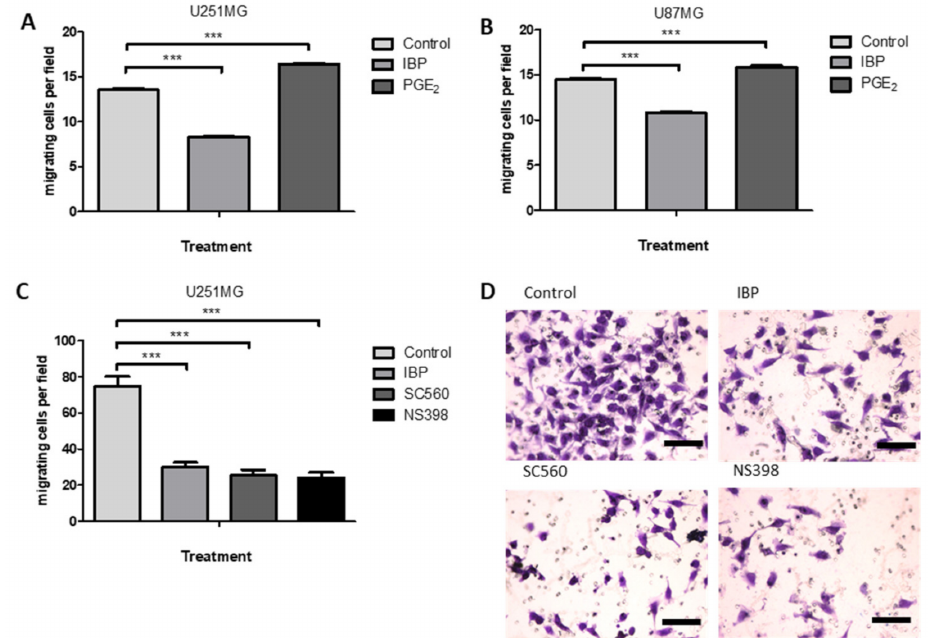
Figure 5. Opposing effects of PGE 2 and COX inhibitors on GBM cell migration. Cells were treated with PGE 2 (10 µ M), IBP (25 µ M), SC560 (50 µ M) or NS398 (50 µ M) for 48hours, with the final 12